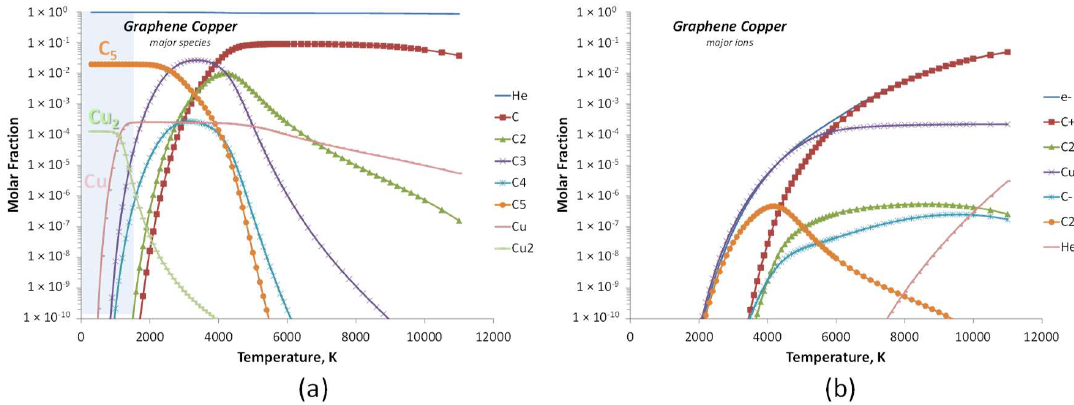
Figure 15. Calculated equilibrium species for GrCu conditions at a total pressure of 530 mbar: ( a ) major species with the cold cathode region schematized in the blue area and ( b ) major ions.